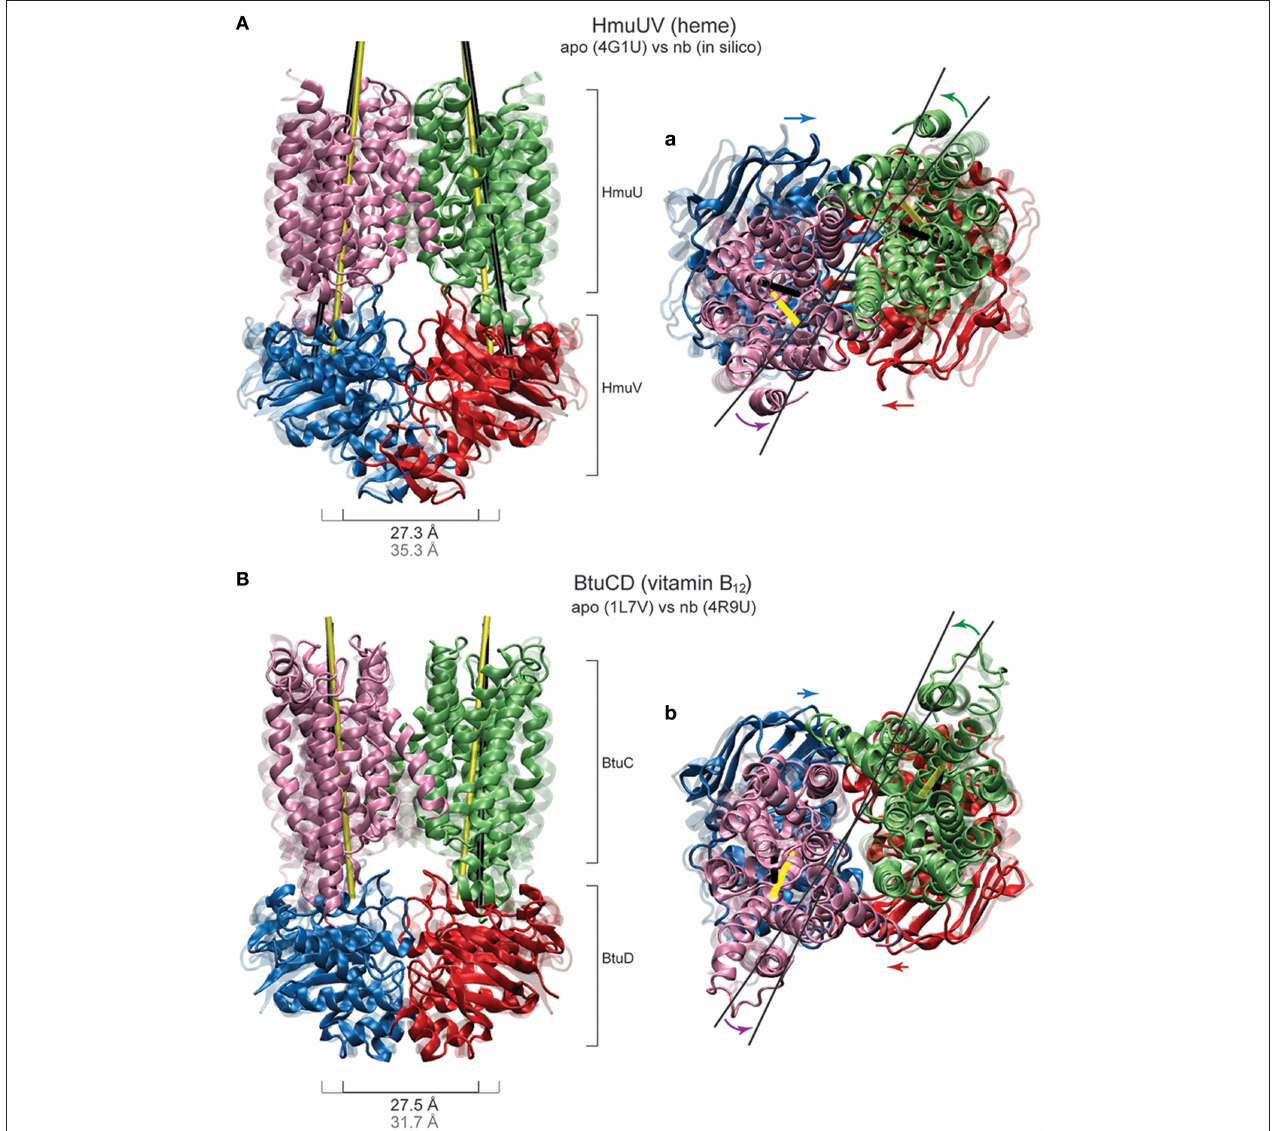
FIGURE 8 | Coupled domain dynamics in HmuUV and BtuCD. Comparison of nucleotide-induced domain motions in the heme and the vitamin B 12 ABC transporter. (A,a) The HmuUV apo conformation (transparent ribbons) and a single ligand-complexed structure from the simulations (solid ribbons) are superimposed (with the two NBDs being aligned). In the front view perspective (A) , the switching of the NBD dimer from the open to the closed shape is apparent. Corresponding values of the NBD separation are given. The tilting of each TMD is visualized by the change in the orientation of the long principle axes, depicted as thick black/yellow lines for the apo/complexed structure. In the top view perspective (a) , the coupling of linear motions of the NBDs and rotational motions of the TMDs is indicated by colored arrows. The rotational shift of the TMDs is highlighted by thin black lines. (B,b) The apo and AMP-PNP bound crystal structure of BtuCD (transparent and solid ribbons, respectively) are superimposed with the two NBDs being aligned. Similar perspectives as in (A,a) are employed to best illustrate the similarity to HmuUV in the coupling of domain